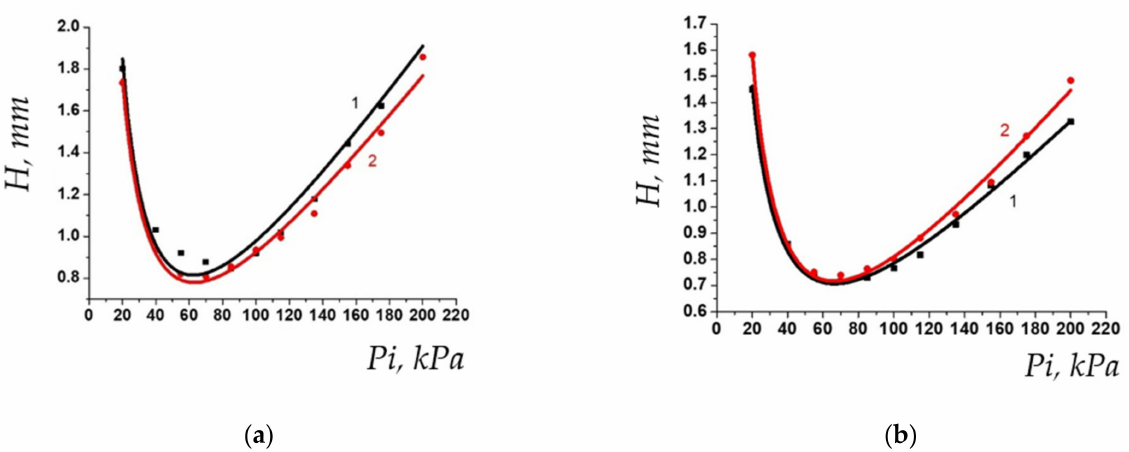
Figure 4. Van Deemter curves for the column based on PTBSN before (curve 1, black) and after (curve 2, red) heating cycles using method 1 for n -butane ( a ) and n -hexane ( b ).